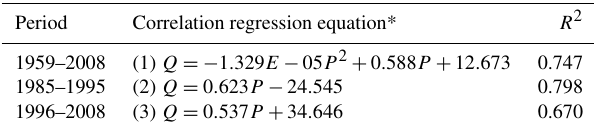
Table 4. Statistical regression analysis and statistical models for runoff and precipitation in different